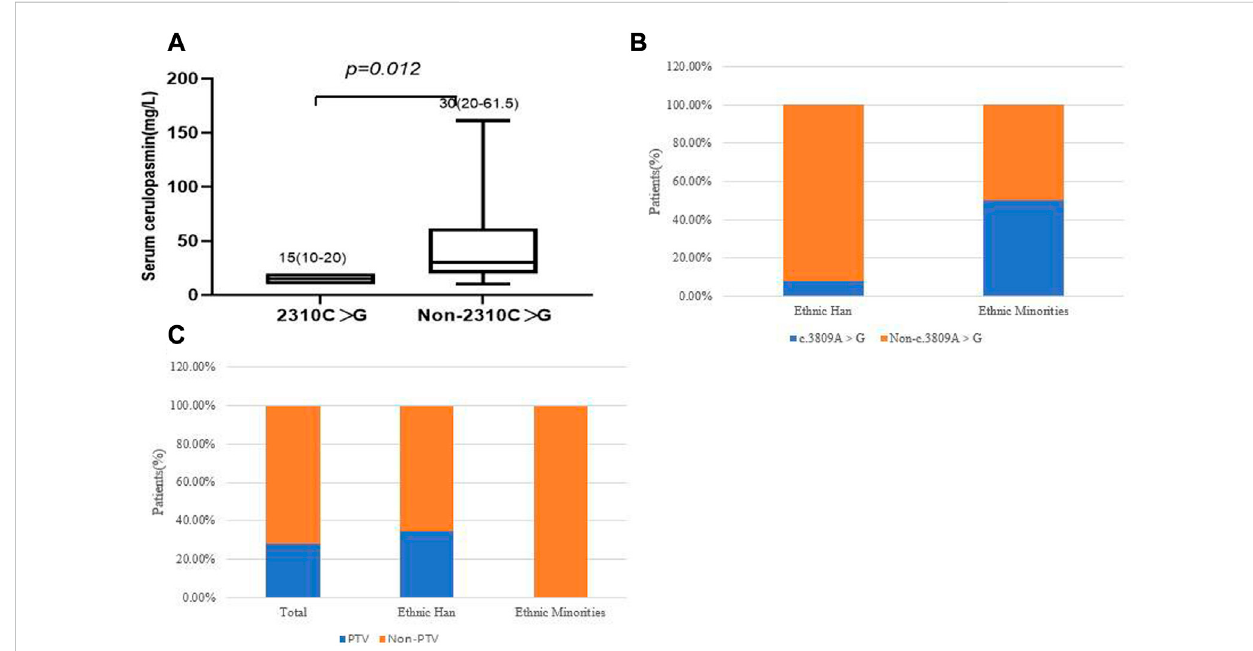
FIGURE 5 (A) Correlationofc.2310C > Gandserumceruloplasminlevel. (B) correlationofc.3809A > Gandethnicgroups. (C) ThefrequencyofPTVindifferent ethnic